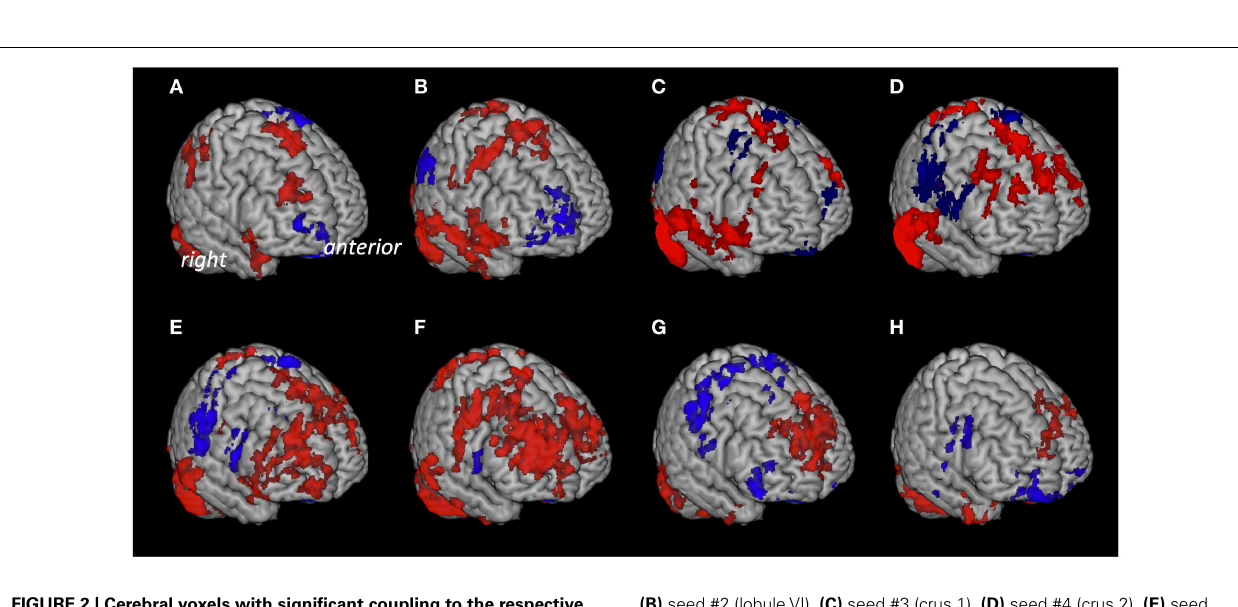
(B) seed #2 (lobuleVI), (C) seed #3 (crus 1), (D) seed #4 (crus 2), (E) seed #5 (lobuleVIIb), (F) seed #6 (lobuleVIII), (G) seed #7 (lobule IX), (H) seed #8 (lobule